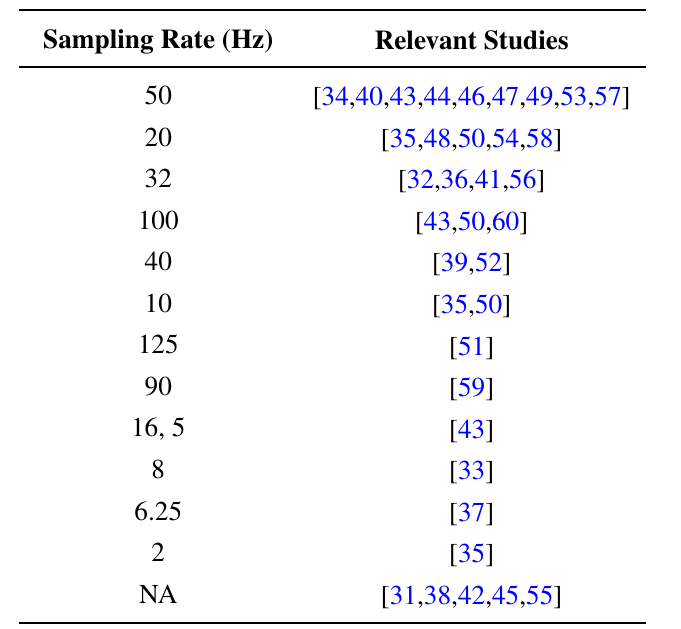
Table 13. Sampling rates used in online activity